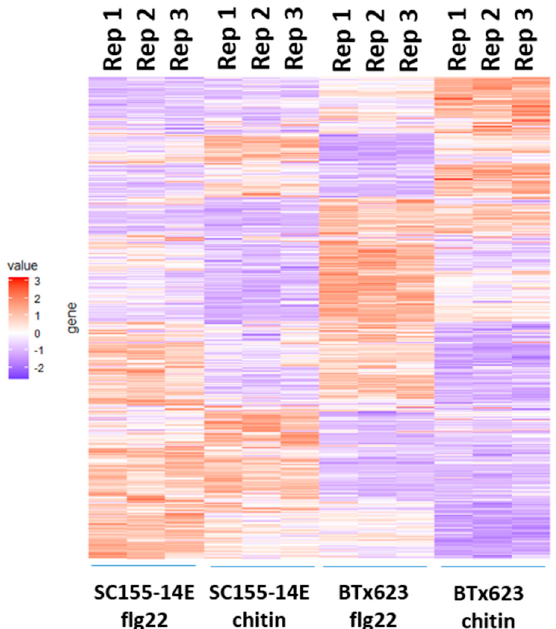
Figure 6. Heat map of transcriptomic response induced by MAMPs in BTx623 and SC155-14E. Three replicates per treatment were analyzed. The gene expression values were normalized as z-scores. The color turns from purple to red as the value increase.